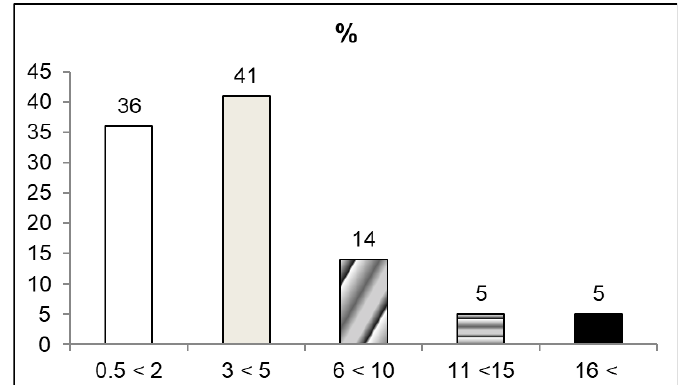
Figure 3. The percentage of injuries related to training hours